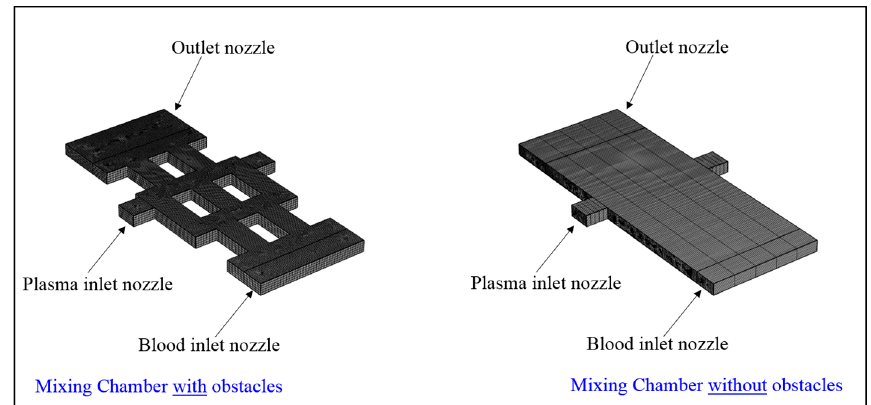
Figure 2. Seamless mesh employed for two mixing chambers with different configurations.